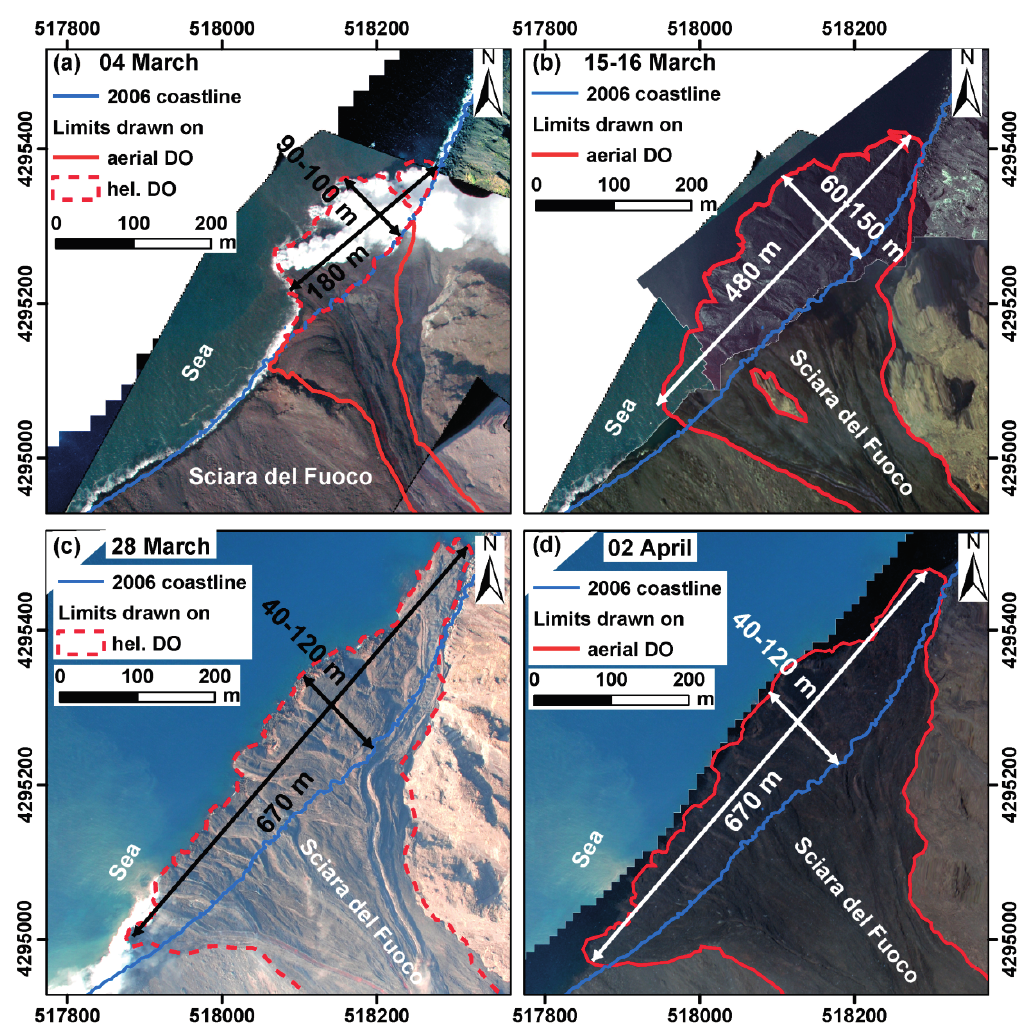
Figure 9. Test 3—2007 eruption, Stromboli: temporal evolution and dimensions of the fan produced by the main lava flow. ( a ) 04 March; ( b ) 15–16 March; ( c ) 28 March; ( d ) 2 April. The pre-eruption coastline (2006) is drawn in blue, continuous and dashed lines are limits drawn on an aerial and a helicopter (hel.) DOs,